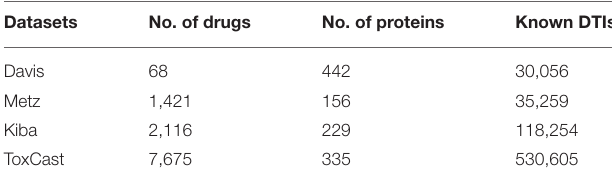
TABLE 1 | Binding affinity benchmark datasets